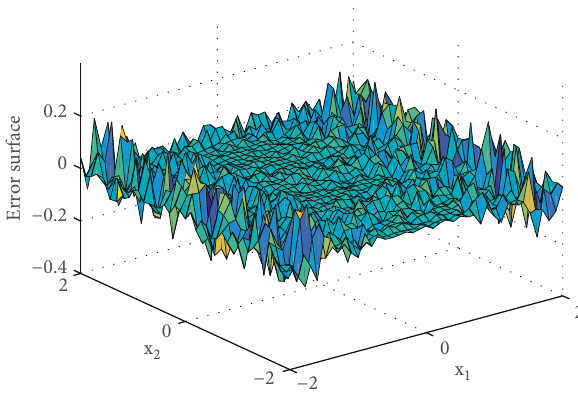
Figure 8: SIF approximation error of